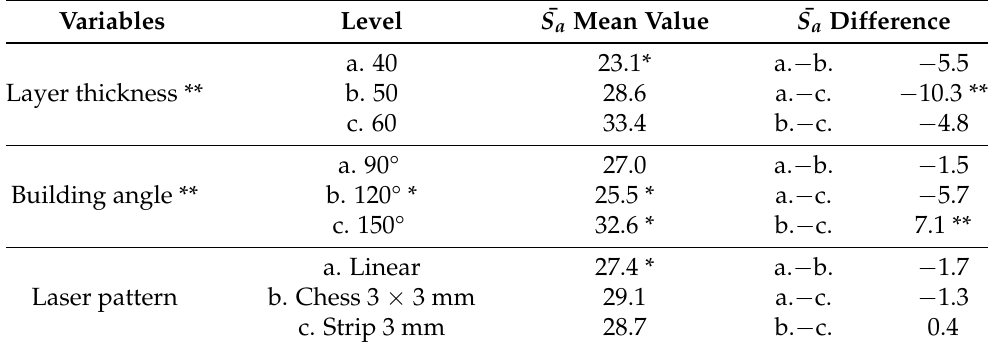
Table 10. Optimum conditions and main variables for red surface ( RS ): S a mean value for each level of variables ( − 1, 0, +1).